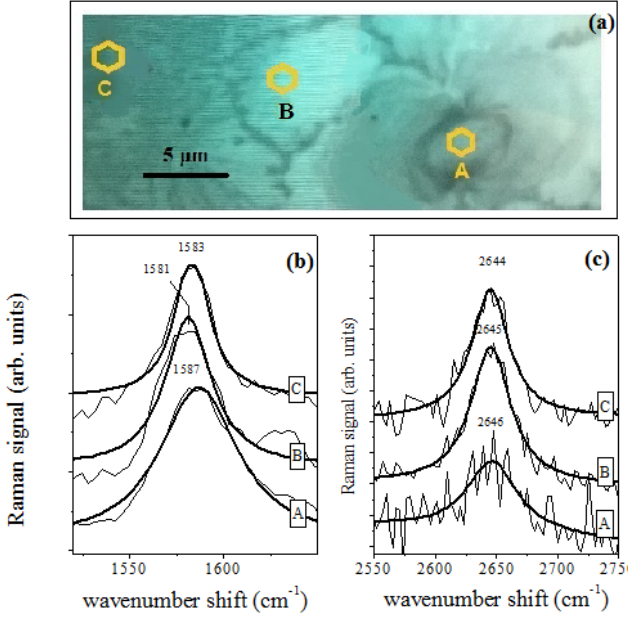
Figure 6. ( a ) Pictures of the Raman acquisition positions (yellow areas) at different distances from the cell center ( Position A). ( b ) G mode Raman spectra acquired in the A, B and C positions. The data are arbitrarily shifted along the y-axis. ( c ) 2D mode Raman spectra acquired in the A, B and C positions. The pH value estimates are 7.8, 10.0 and 9.1, in the A, B and C positions,